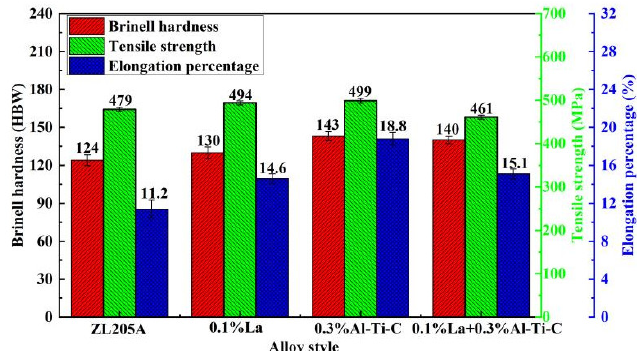
Figure 4. Microstructure of the alloys after aging: ( a ) ZL205A alloy, ( b ) ZL205A + 0.1%La alloy, ( c ) ZL205A + 0.3%Al–5Ti–0.8C alloy, and ( d ) ZL205A + 0.1%La + 0.3%Al–5Ti–0.8C alloy.